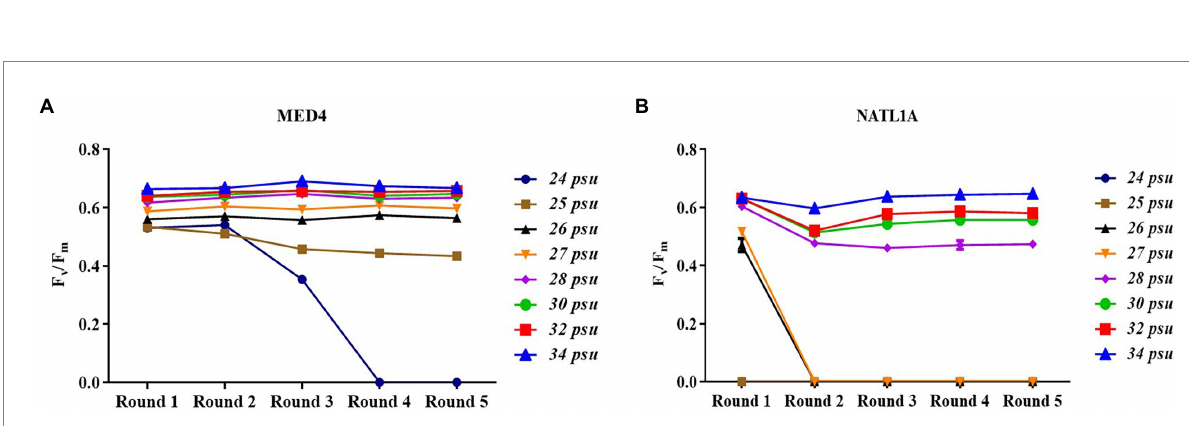
FIGURE 3 Dark-adapted photochemical efficiency (Fv/Fm) of Prochlorococcus strains MED4 (A) and NATL1A (B) growing in different salinities during